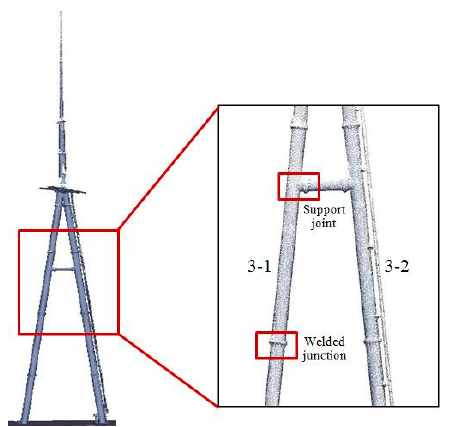
Figure 6. Point clouds of an A-shaped frame.